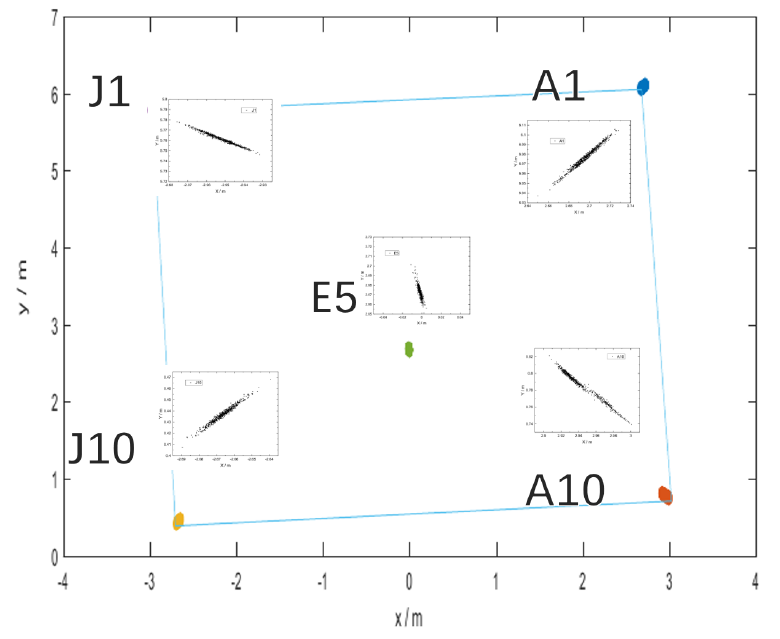
Figure 10. Positioning results in the four corners and central area of the positioning